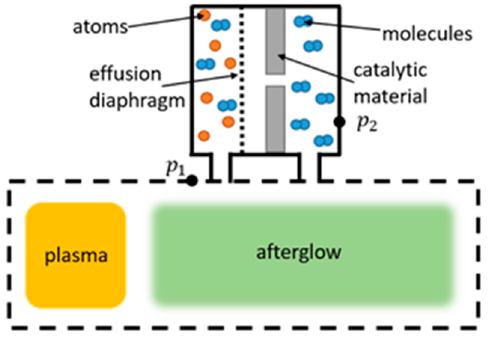
Figure 11. Schematic of a Wrede–Harteck gauge, where 𝑝 (cid:2869) and 𝑝 (cid:2870) are pressures measured inside the plasma chamber and inside the Wrede-Harteck gauge, respectively. plasma chamber and inside the Wrede-Harteck gauge,